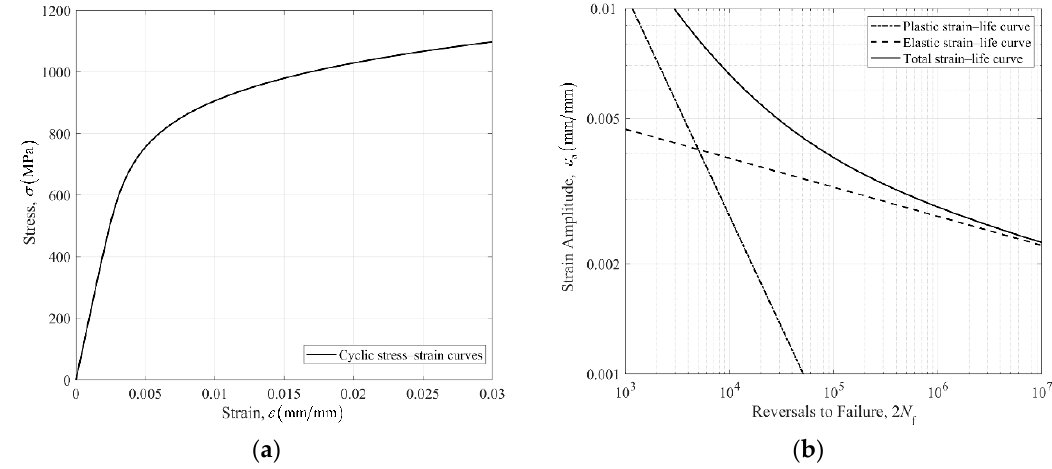
Figure 4. ( a ) Cyclic stress–strain curve of 42CrMo based on the Ramberg–Osgood relationship, ( b ) strain–life curve of 42CrMo based on Manson–Coffin equation.